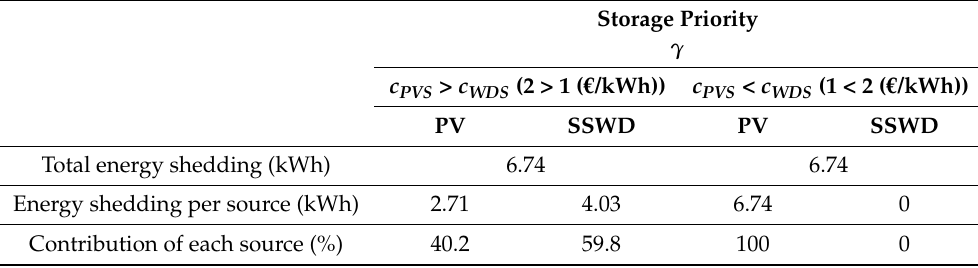
Figure 10. PV and SSWD shedding curves without optimization by applying the γ coefficient in the case of: ( a ) Table 4. Energy shedding calculation for the γ coefficient in the case of storage priority.